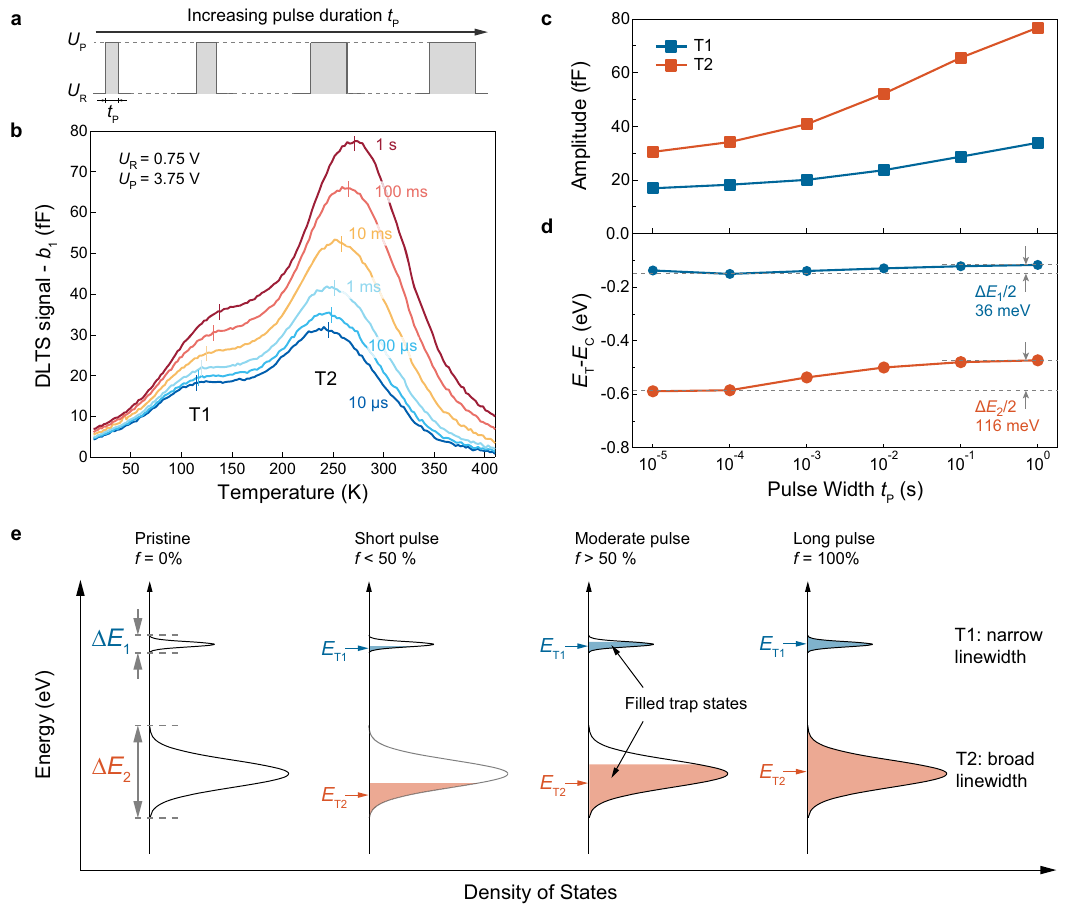
Fig.3|Defectlevellinewidthandcontrolofdefect fi lling.a Asimpleschemeand b theDLTStemperaturesweepatvariouspulsewidth t P values.Here,thereference and pulse voltages are fi xed at 0.75 V and 3.75 V respectively. c Change of peak amplitudes and d measured trap energies with respect to t P . Each data point is obtainedfromthetwopeakpositionsinpanelb.Thegraydashlineinpaneldmarks